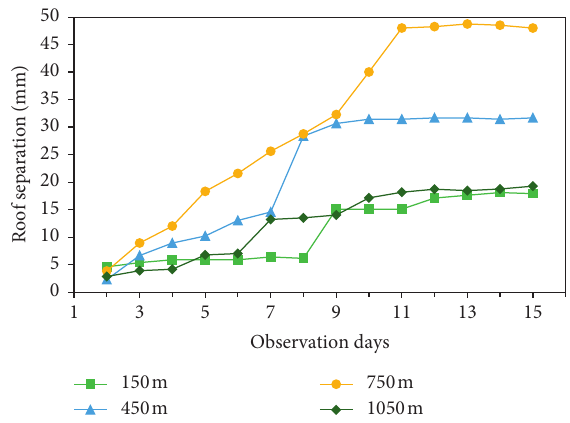
Figure 4: Convergence diagram of surrounding rock of roadway. Figure 5: Roof separation of roadway.